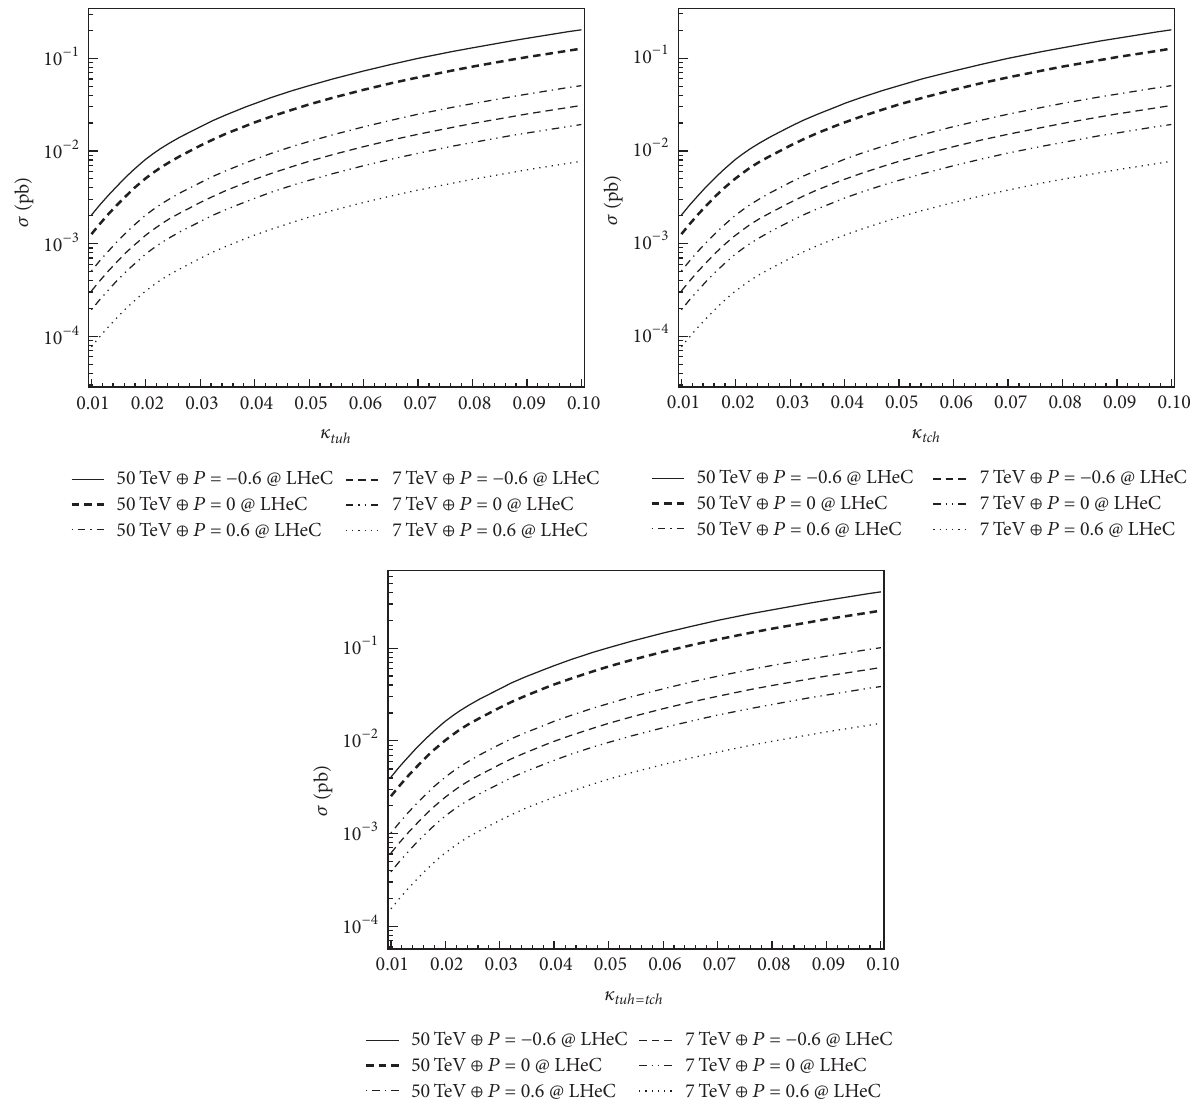
Figure 3: The same as Figure 2 but for 𝐸 𝑒 =